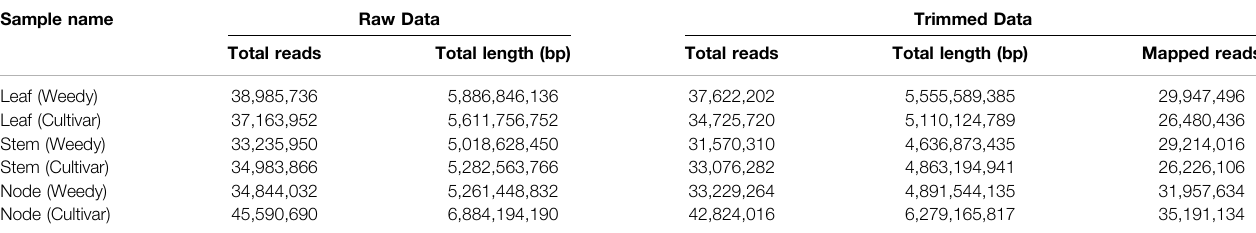
TABLE 1 | The summary of the sequencing data by a high-throughput DNA sequencing platform in the weedy type and cultivar type